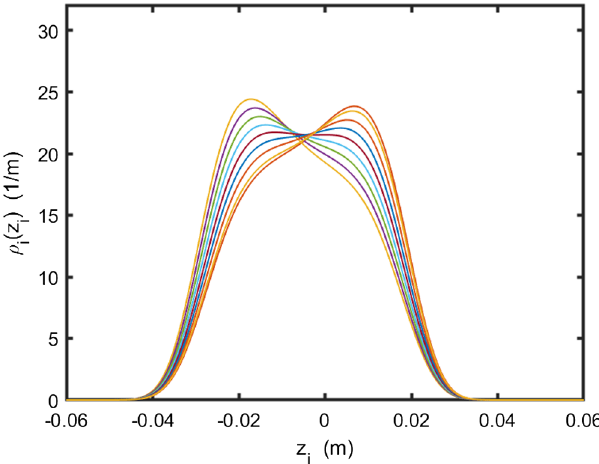
FIG. 14. Longitudinal impedance Z ð f Þ